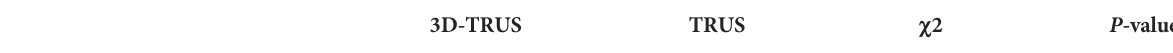
TABLE 5 Comparison of detection rate of 3D-TRUS and TRUS.